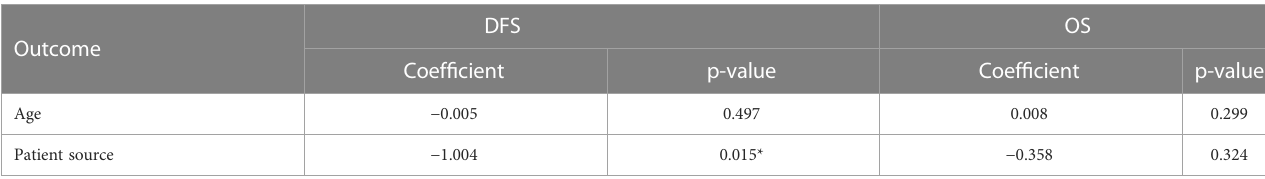
DFS, disease-free survival; OS, overall survival; *p ＜